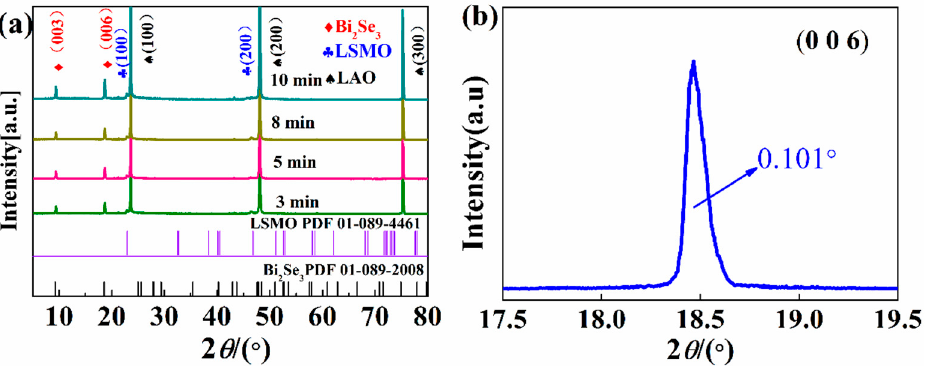
Table 1. The EDX and thickness results of the Bi 2 Se 3 films with deposition time.